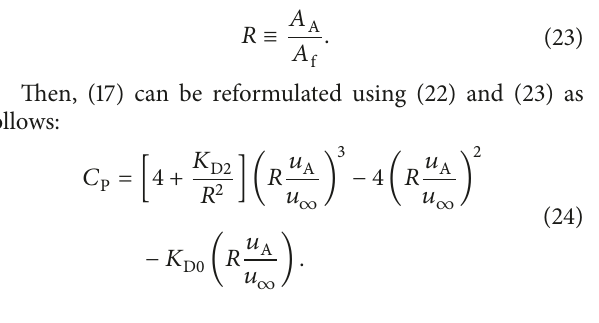
Figure 7: Optimum nondimensional actuator velocity 𝑢 𝑢 /𝑢 | ∞ 𝜂 load =1 as a function of the drop coefficient A colormap is matched to that of Figure 6. For values below − 1, the power coefficient becomes positive, and no energy can be extracted; below − 4/3, an optimum actuator velocity no longer exists, since the best efficiency is obtained for standing